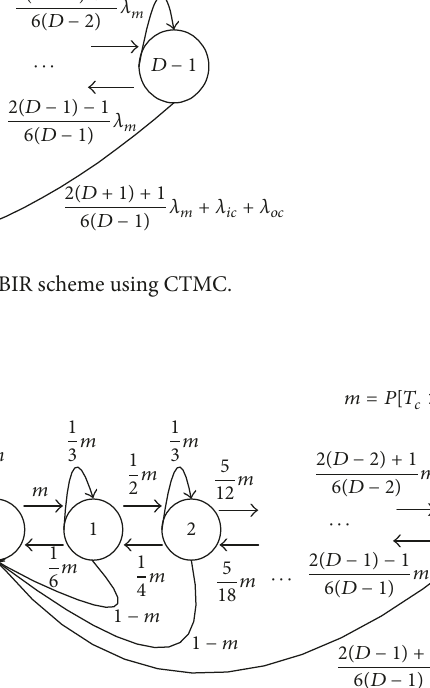
Figure 3: State-transition diagram of the DBIR scheme using